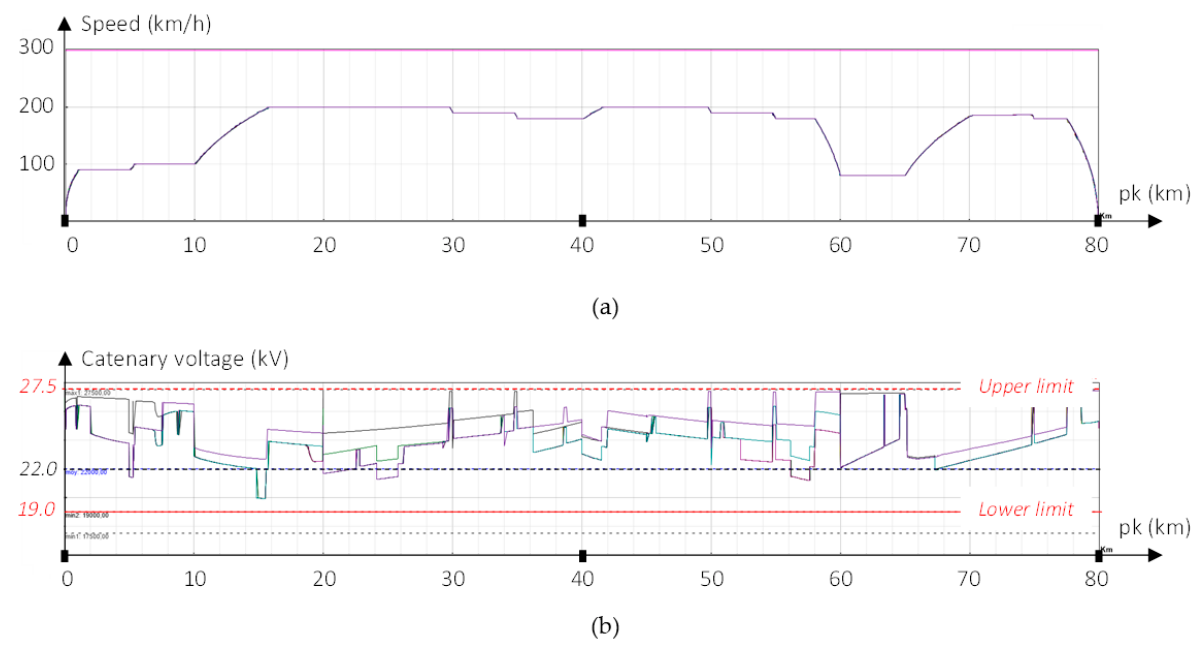
Figure 7. Simulation results for the nominal case: ( a ) speed profiles (10 overlapping curves); ( b ) catenary voltage. The voltage must remain between the lower limit (19 kV, red continuous line) and the upper limit (27.5 kV, red dashed line).